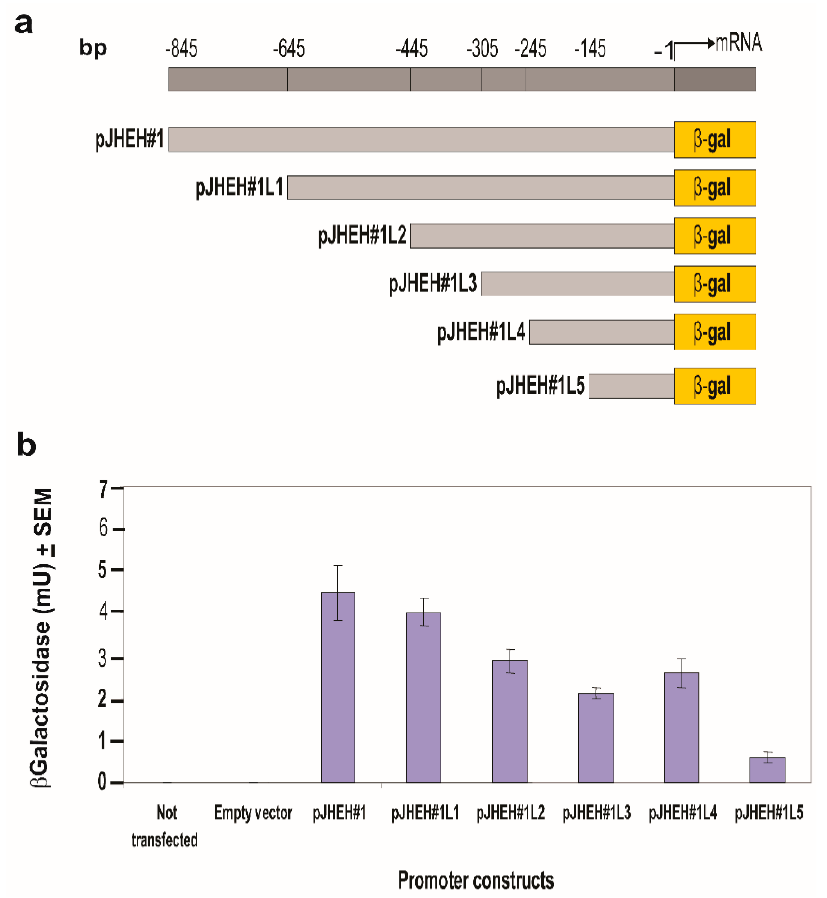
Figure 5. Testing jheh 1 different promoter sequence lengths ( a ) for transcriptional activity ( b ) by cloning them into plasmid pCaSpeR-AUG- β gal, transfecting D.Mel2 cells with the recombinant plasmid and assaying 2 × 10 5 cells for β -galactosidase activity expressed in milliunits (mU). Controls were D.Mel2 cells that were not transfected or transfected with empty plasmid.